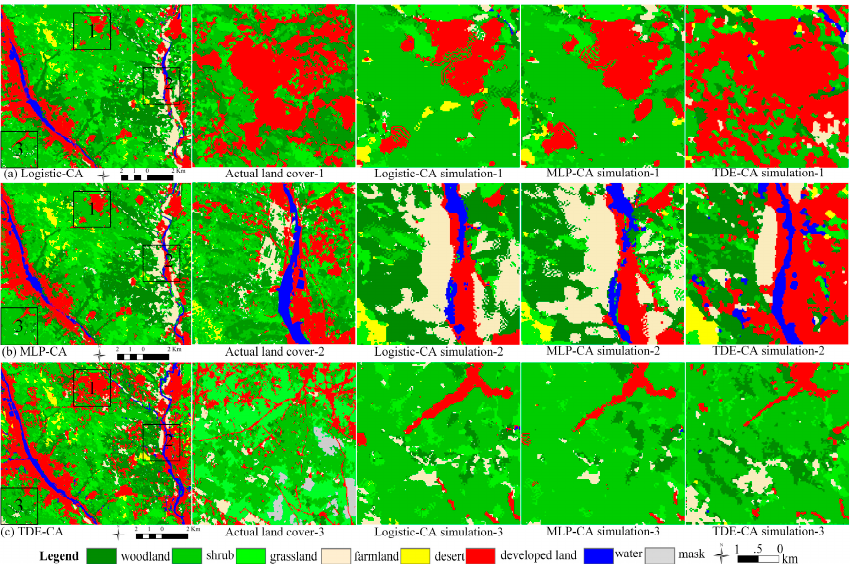
Figure 8. The spatial distribution of land cover of different CA models. ( a ), ( b ), and ( c ) respectively present simulation results of the logistic-CA, the MLP-CA, and the TDE-CA.